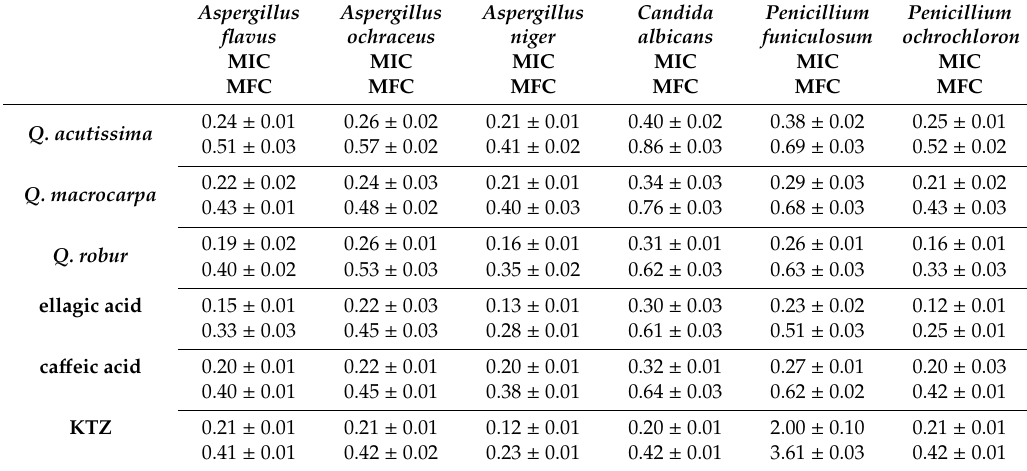
Table 4. Minimum inhibitory (MIC) and fungicidal concentration (MFC) of Q. acutissima, Q. macrocarpa and Q. robur outer bark extracts (mg mL − 1 ) as well as phenolic standards.